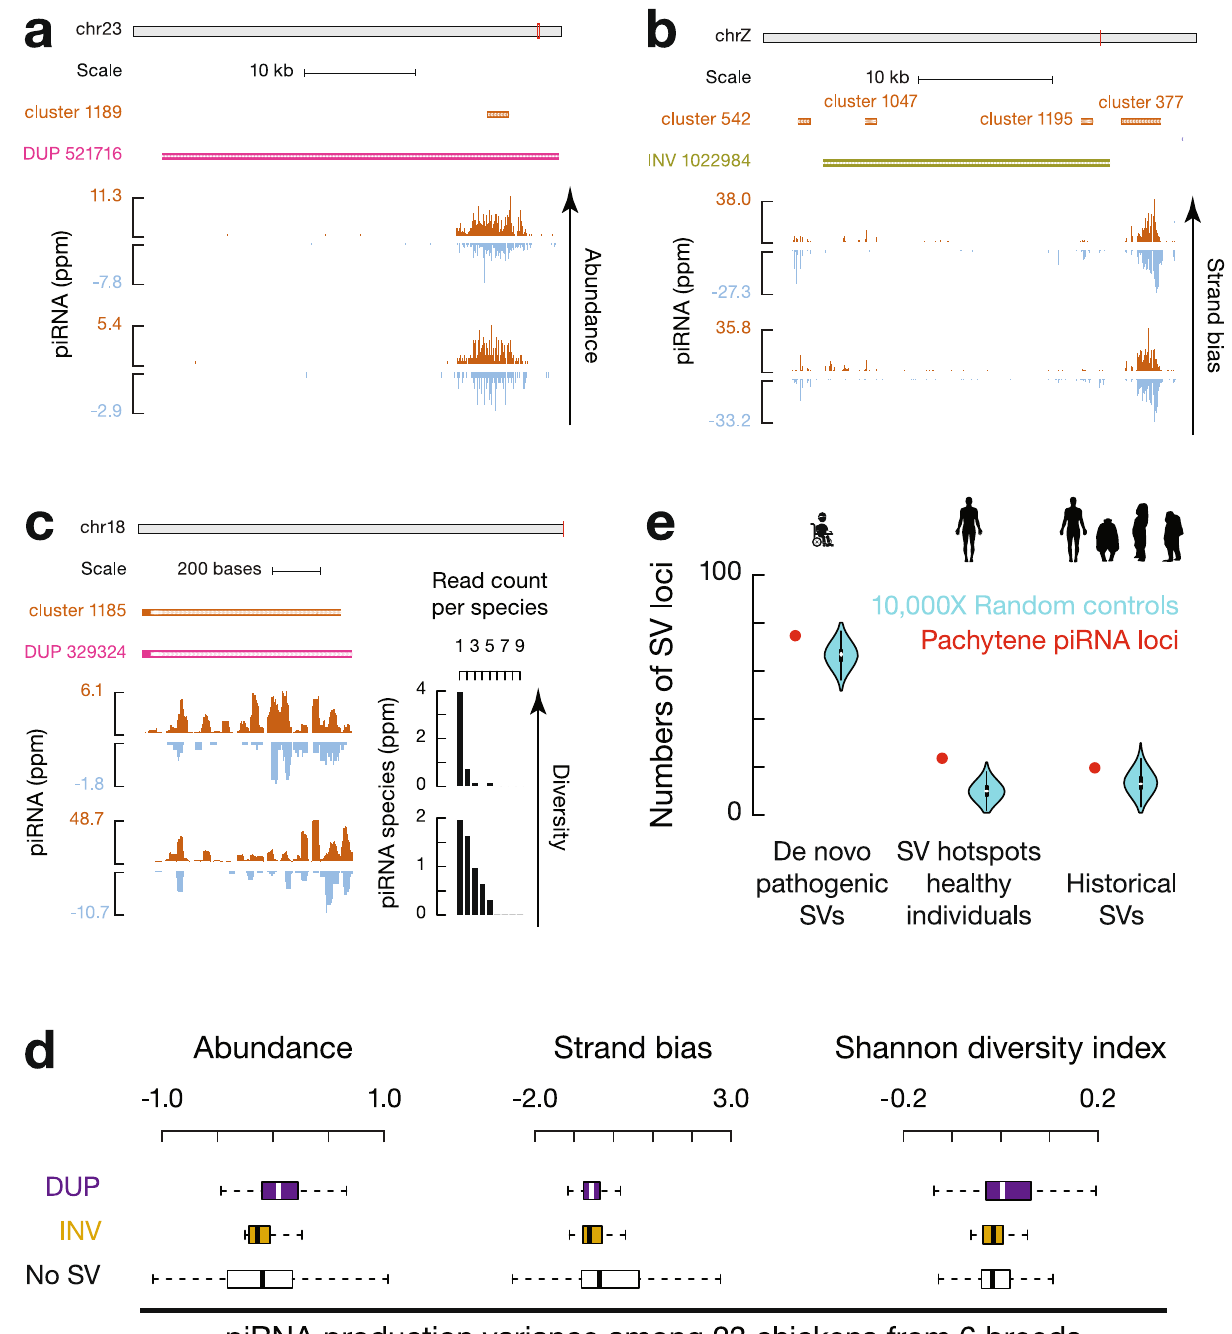
Fig. 3 | Conserved mechanisms to achieve piRNA plasticity. a Example of a duplication overlapping with a piRNA locus and its piRNA abundance from two chickenindividuals.BluerepresentsWatsonstrandmappingreads;Redrepresents Crick strand mapping reads. Ppm, parts per million. b Example of an inversion overlapping with two piRNA loci (cluster 1047 and cluster 1195) along with their nonoverlapping control piRNA loci (cluster 542 and cluster 377) and their piRNA abundance from two chicken individuals. Blue represents Watson strand mapping reads; Red represents Crick strand mapping reads. Ppm, parts per million. c ExampleofaduplicationoverlappingwithapiRNAlocus.(Left)piRNAabundance from two chicken individuals. Blue represents Watson strand mapping reads; Red represents Crick strand mapping reads. Ppm, parts per million. (Right) piRNA